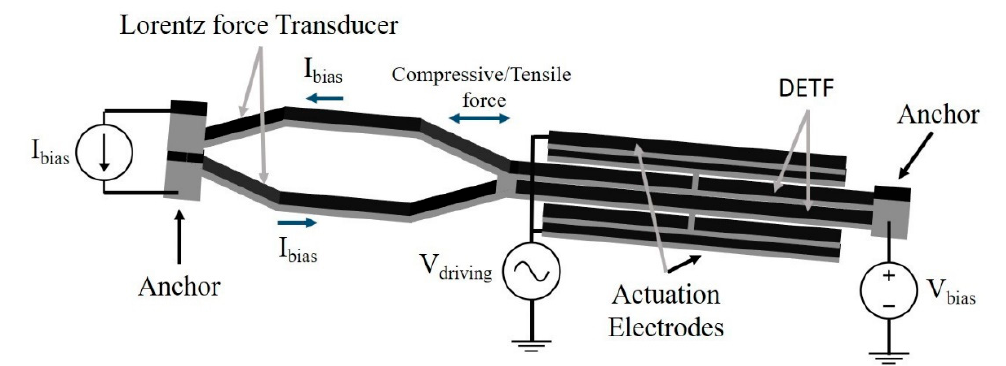
Figure 1. Scheme of the magnetometer composed by a DETF and hexagonal-shaped Lorentz force transducer. All the electrical connections used during the characterization are also represented.